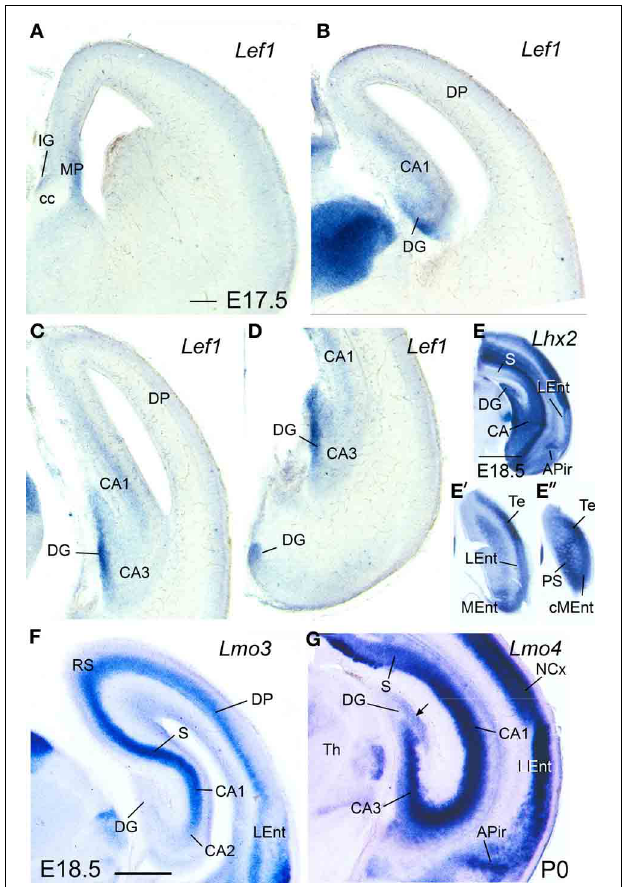
FIGURE 5 | Expression of Lef1, Lhx2, Lmo3 , and Lmo4 in mouse embryonic telencephalon at prenatal or neonatal ages. Digital images of coronal sections of prenatal or neonatal mouse telencephalon (E17.5, E18.5, or P0), at intermediate (A,B,F) or caudal (C–E (cid:3)(cid:3) ,G) levels, hybridized for Lef1, Lhx2, Lmo3 , or Lmo4 . For abbreviations see list. Scale bar: (A) = 200 μ m (applies to A–D,F,G ). (E) = 1mm (applies to E–E (cid:3)(cid:3)